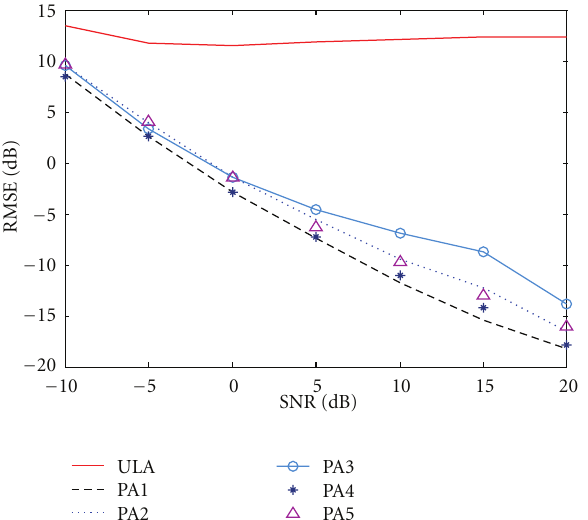
Figure 6: Total RMSE of the MUSIC algorithm for di ff erent configurations where signals are arriving at endfire directions.